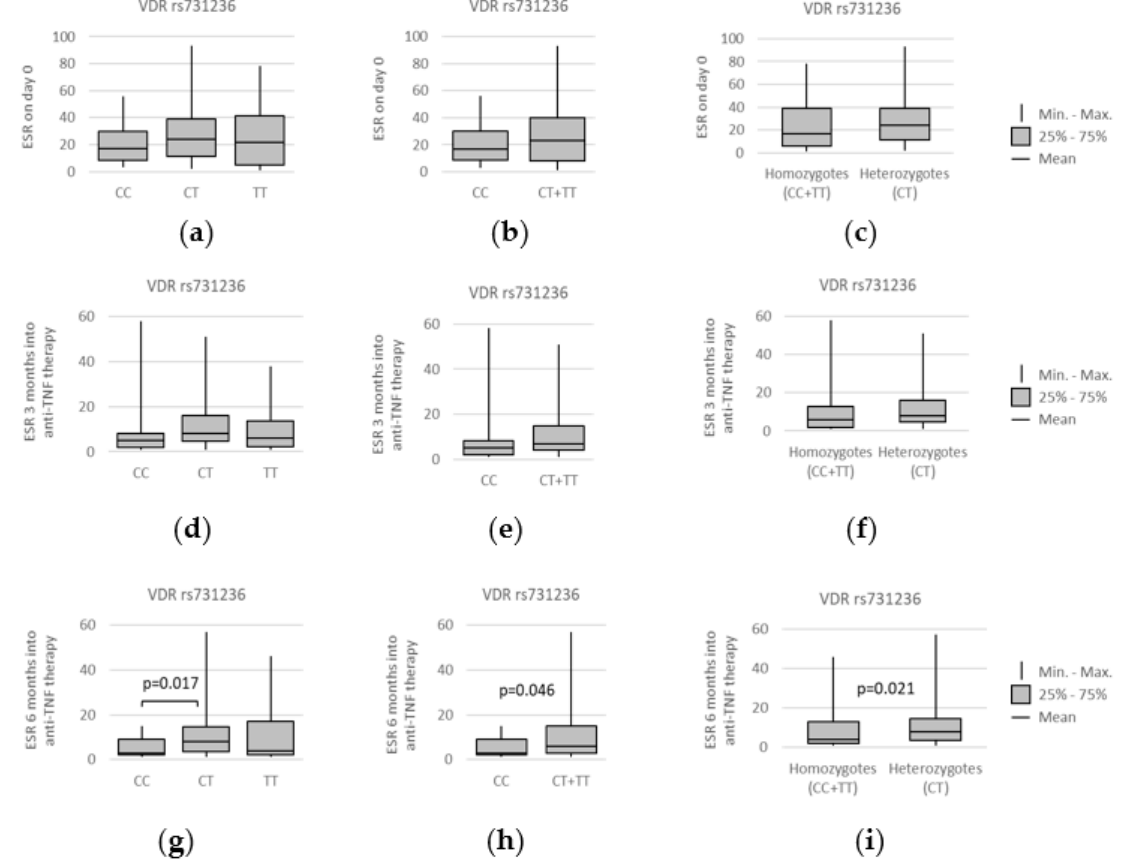
Figure 7. Relationships between VDR rs731236 genotypes and ESR levels at three time points: ( a – c ) prior to anti-TNF therapy, ( d – f ) after 3 months, and ( g – i ) after 6 months of the treatment. The following statistically significant associations were found: ( g ) CC vs. CT , p = 0.017; ( h ) CC vs. CT + TT , p = 0.046; and ( i ) CC + TT vs. CT , p = 0.021. Analysis was performed using unpaired two-sample Wilcoxon test.